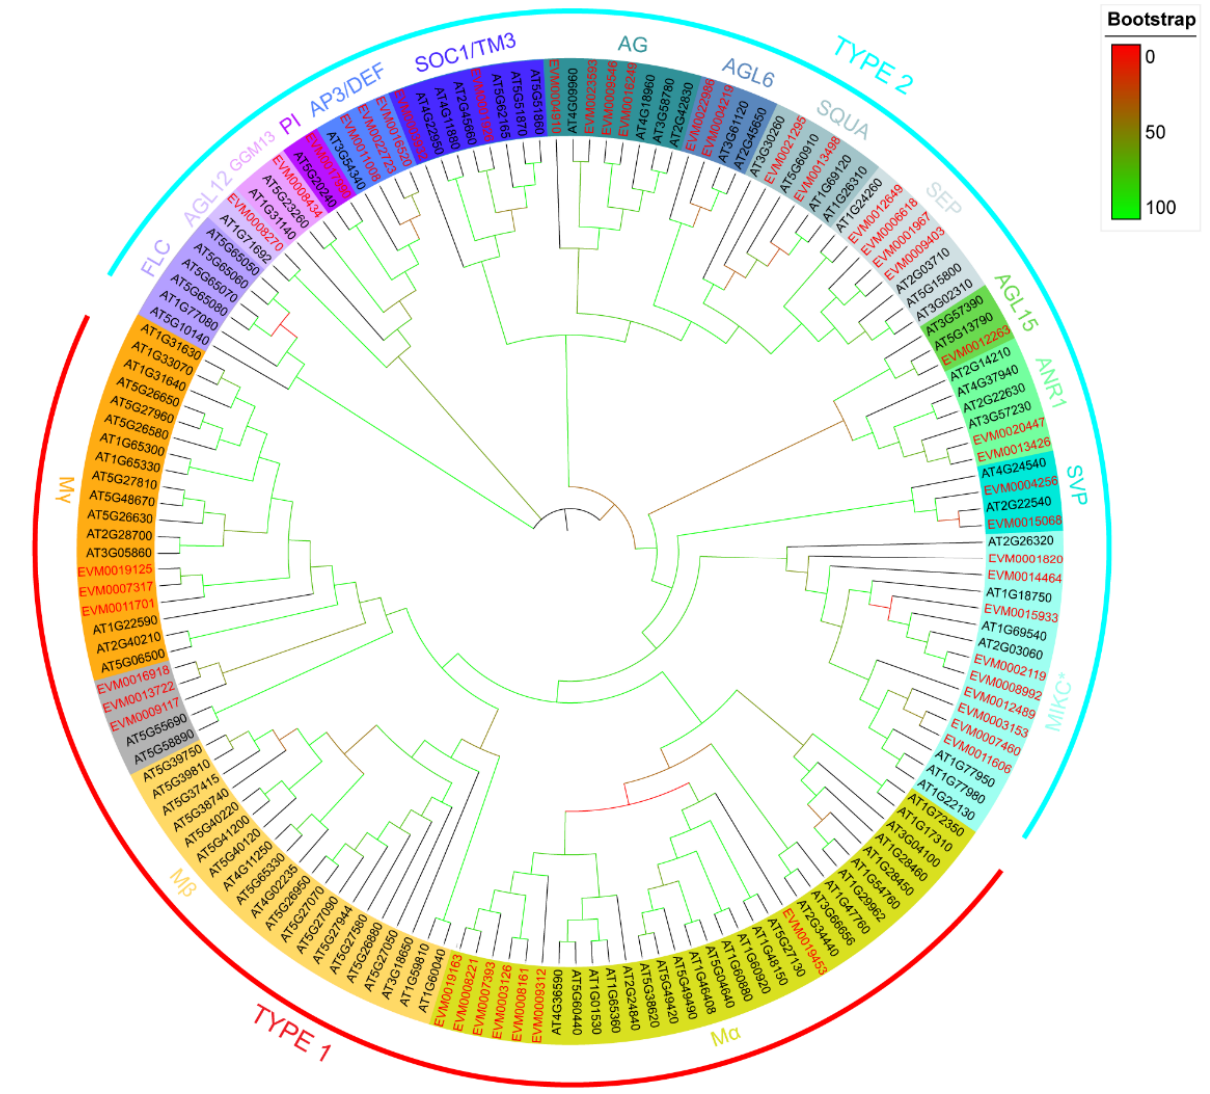
Figure 1. Classification of the A. trifoliata MADS-box subfamilies. Specific lineages are indicated by colours and bracketing. The type I lineages contain M α , M β , and M γ , while the type II lineages contain MIKC* and MIKC C (all other type II subfamilies except MIKC*). The paraphyletic groups of 5 genes, including EVM0009117 , EVM0013722 , EVM0016918 , AT5G55690 and AT5G58890, are col- oured grey because AT5G55690 and AT5G58890 have previously been classified as M β but are